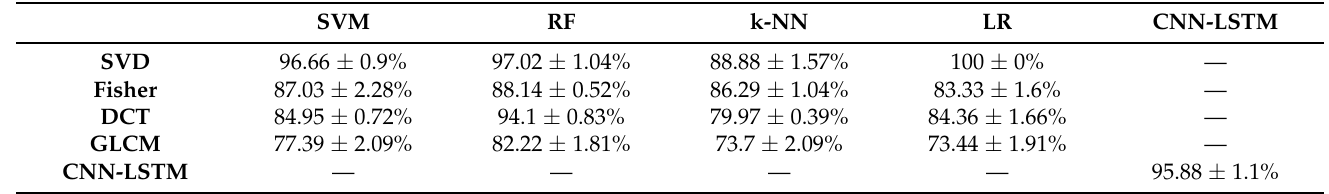
Table 3. Testing performances for all combinations of the feature extraction and classification methods as well as CNN-LSTM using the Sensor-1 large-layout dataset from Coventry-2018 for 15 classes of single-subject and double-subject activities. SVM RF k-NN LR CNN-LSTM